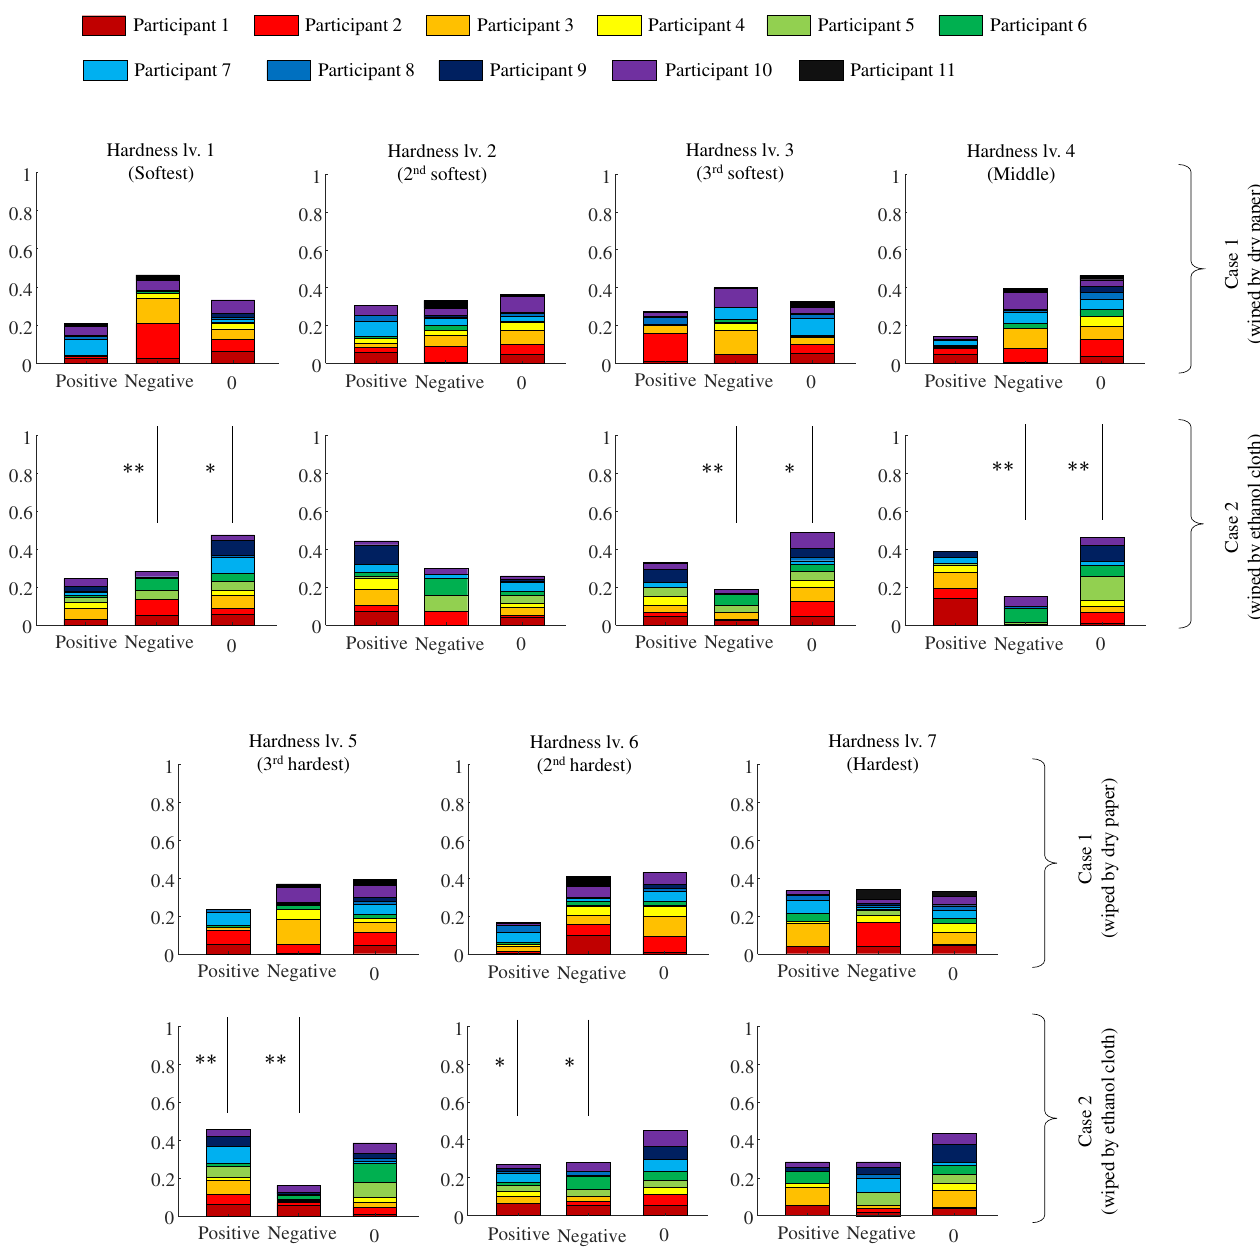
Figure 8. Probability of occurrence of positive, negative, and insignificant β values. The upper and lower sections represent the results under case 1 (wiped by a dry cloth) and case 2 (wiped by ethanol), respectively. Cohen’s d = 0.5. Asterisks * and ** indicate statistical differences in the proportions between cases at p < 0.05 and p < 0.01, respectively. The sum of the proportions for all individuals is 1. Note that the number of slides differs from participant to